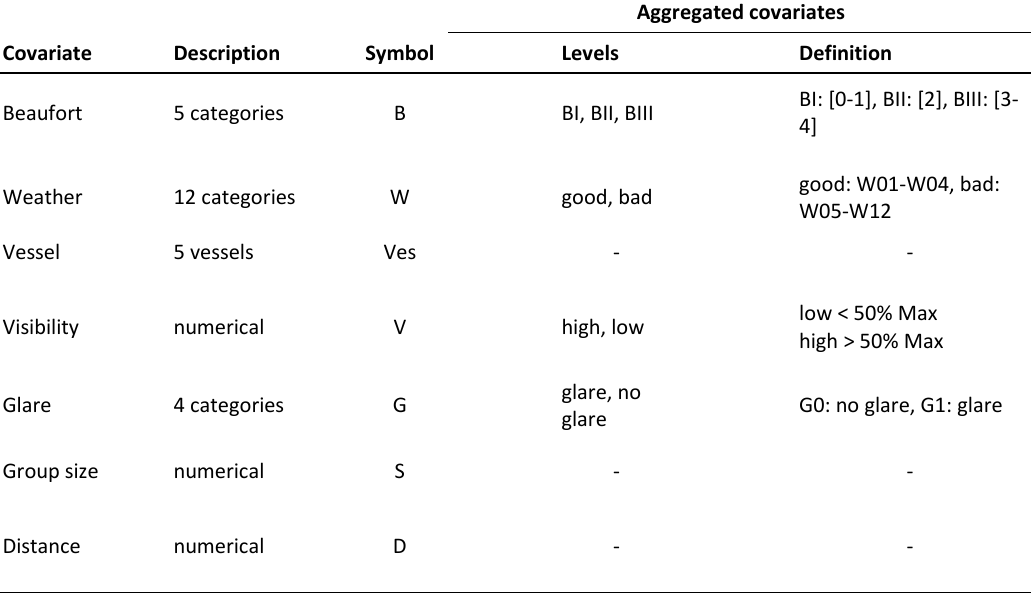
Table 1. Covariates descriptions included to improve model fit. Some covariates were aggregated into levels for